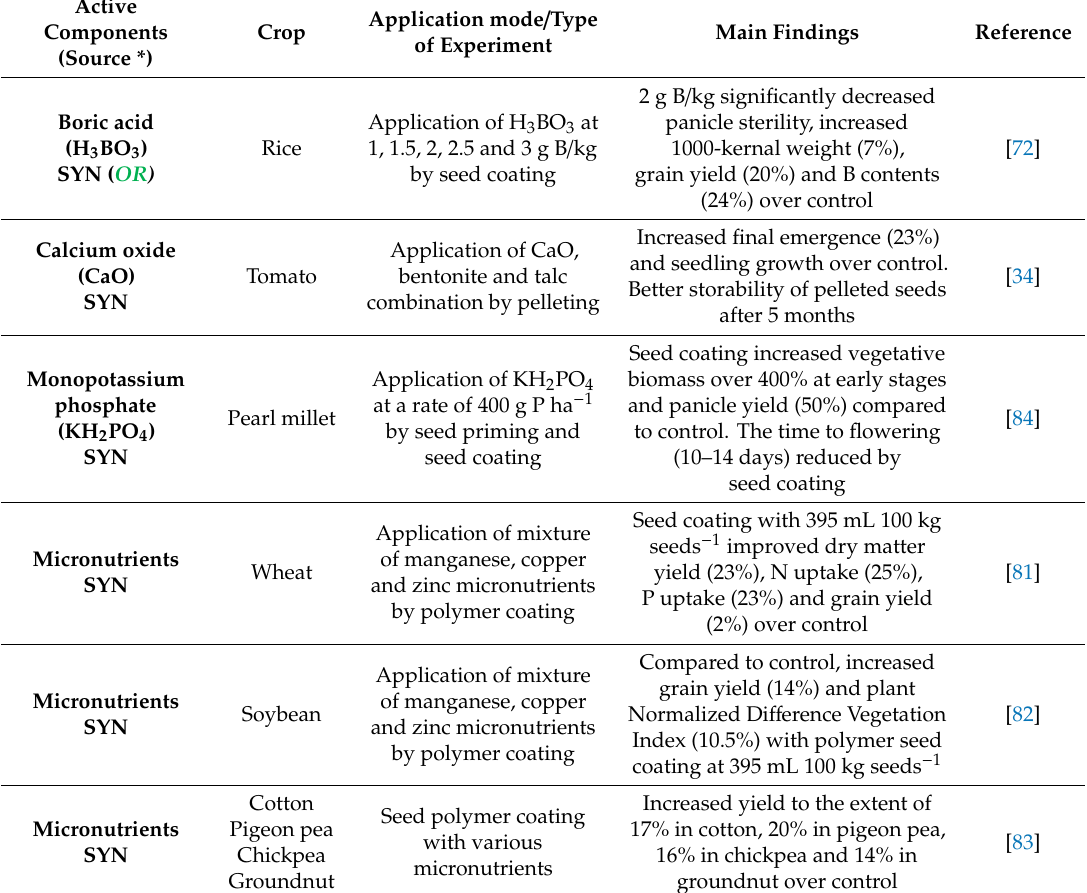
Table 4. Review of plant nutrients applied as seed treatments on seed germination, seedling growth, yield and other measured